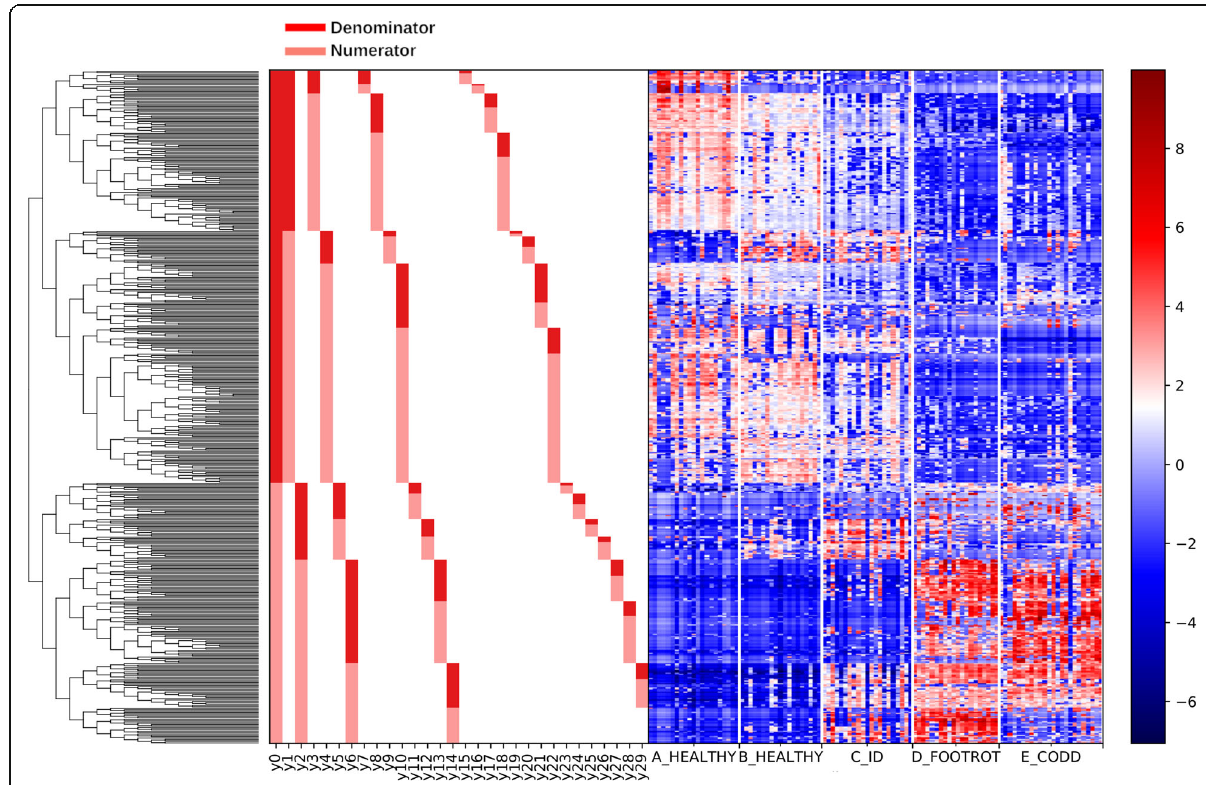
Fig. 4 A dendogram heatmap showing log 10 abundance of ASVs in the foot microbiota at different stages of CODD lesion